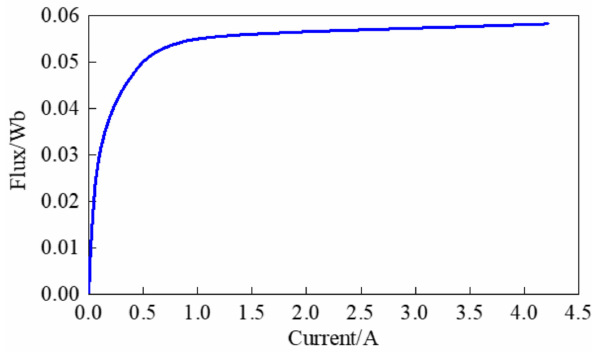
Figure 2. The Φ –I curve of transformer under no-load